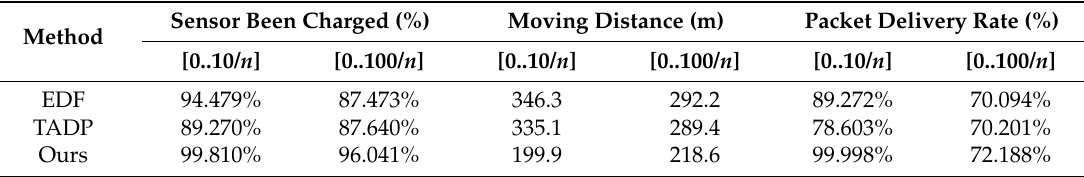
Table 5. Performance comparison between ours and the other